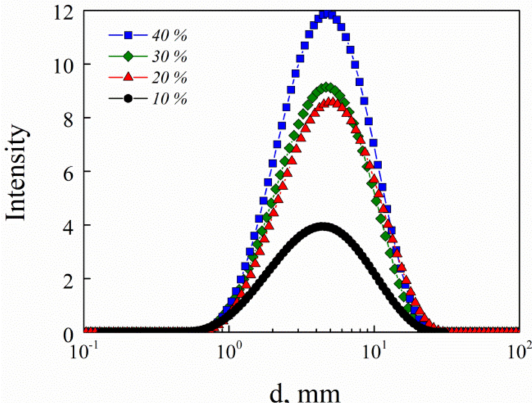
Figure 4. Droplet size distributions of w/o emulsions measured by nuclear magnetic resonance (NMR) at different aqueous phase volume fractions. Aqueous phase contents ( ϕ ) are